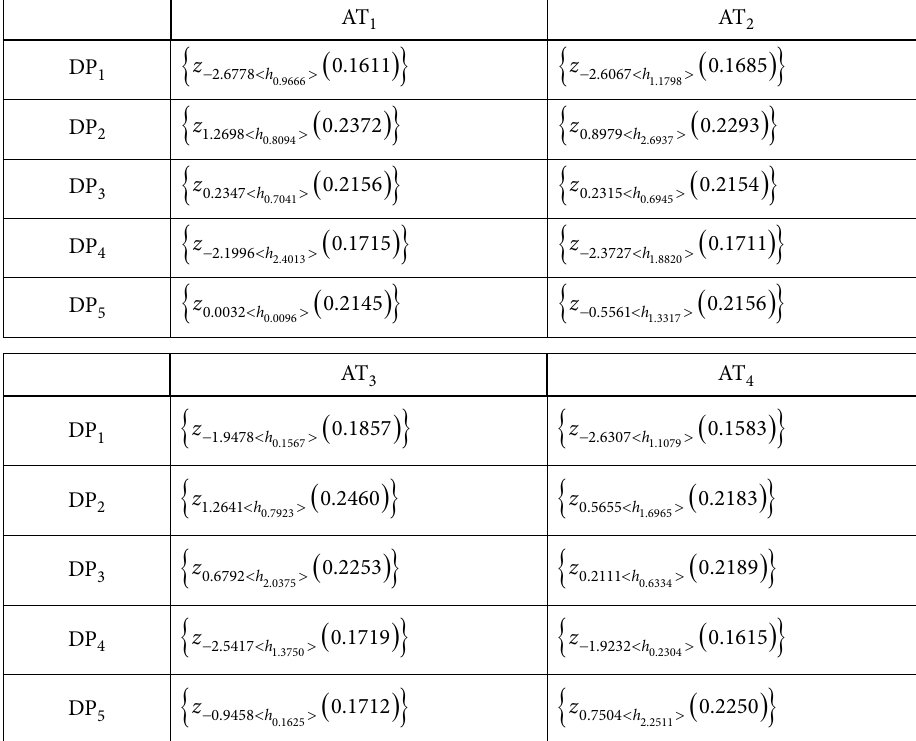
Table 12. The PDHLTSs decision information with prospects weight based on e 2